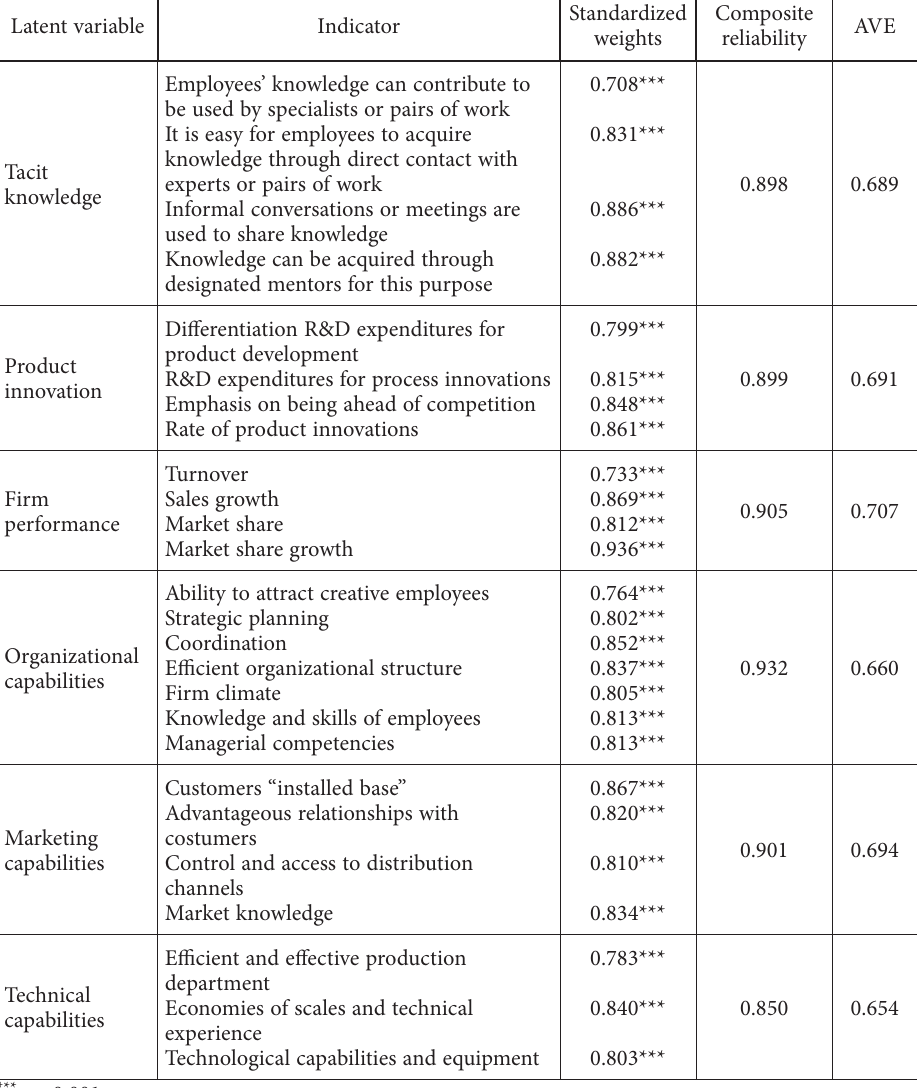
Table 2. Standardized measurement coefficients, composite reliability and AVE Latent